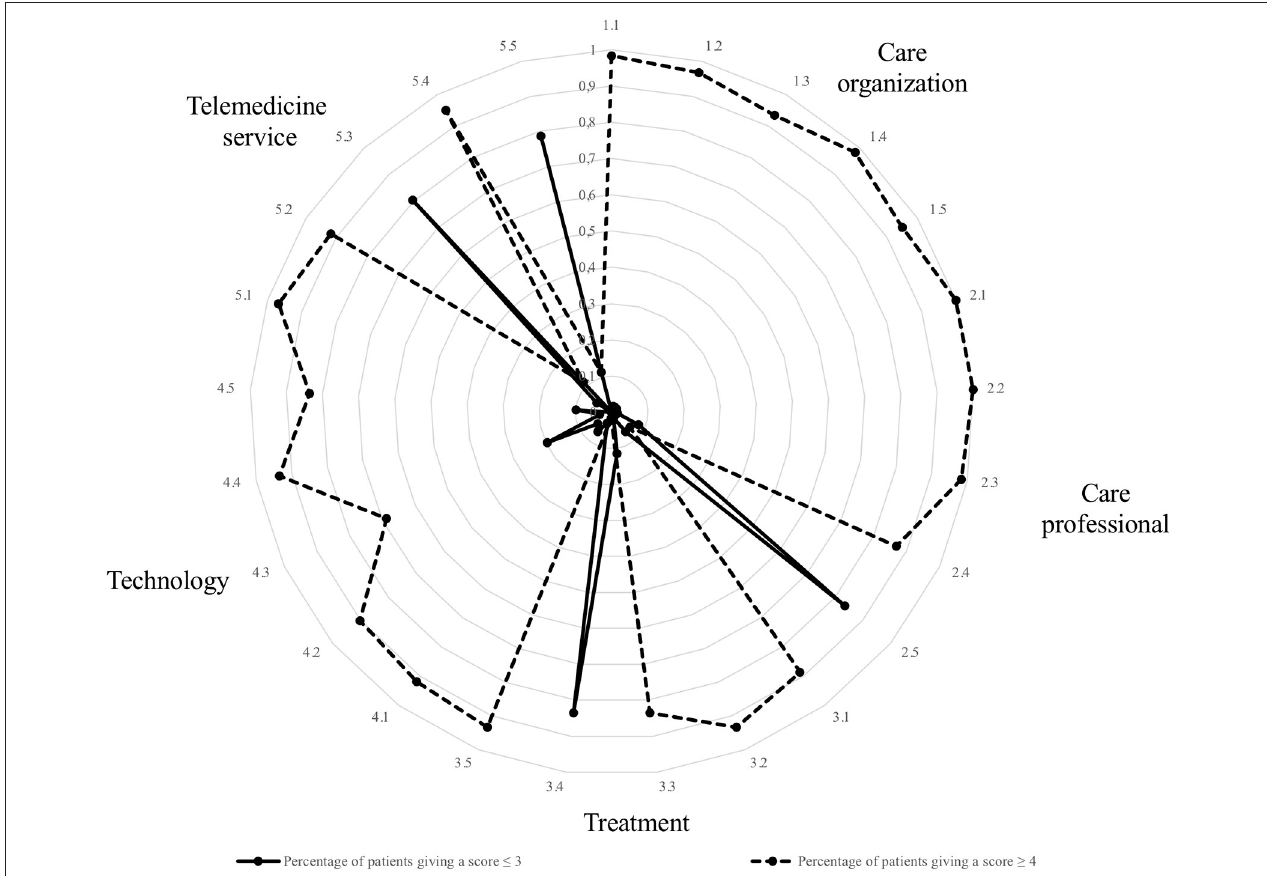
FIGURE 2 | Radar chart of the trust scores from celiac patients assessed through an adapted version of the Patient Trust Assessment Tool (PATAT) questionnaire. Five trust areas were investigated: care organization (1.1–1.5), care professionals (2.1–2.5), treatment (3.1–3.5), technology (4.1–4.5), and telemedicine services (5.1–5.5). The dotted line refers to the patients giving a score ≥ 4 (out of 5) on a Likert scale. The continuous line refers to the patients giving a score ≤ 3. Statements 2.5, 3.4, 5.3, and 5.5 were negative. Regarding trust in telemedicine services, items 5.1, 5.2, and 5.4 received a score of least 4 in 95, 90, and 84% of the cases,